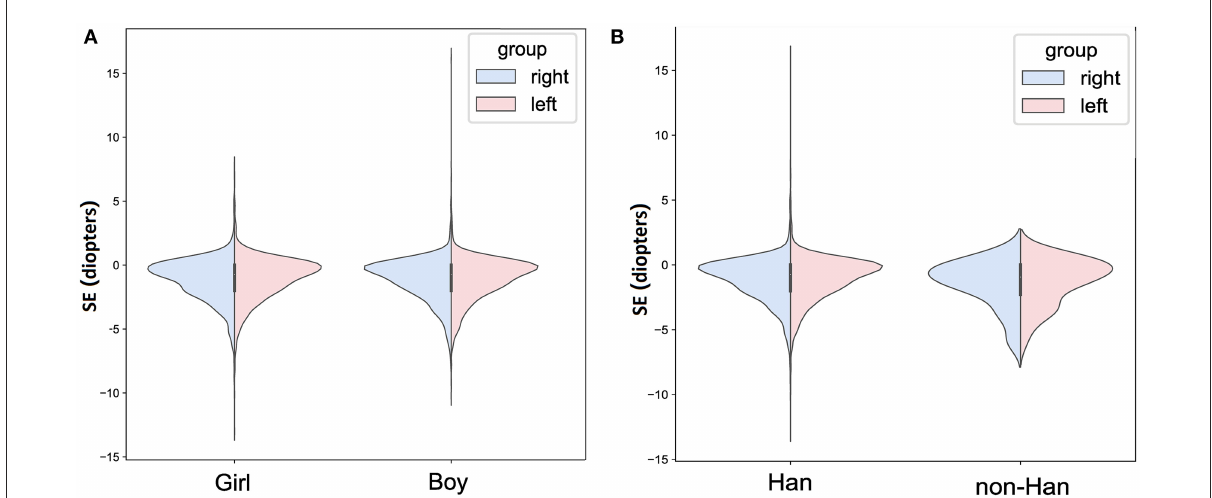
FIGURE1 The bilateral spherical equivalent in different age or grade in primary-school students in Xi’an. (A) The bilateral spherical equivalent in different age; (B) the bilateral spherical equivalent in different grade. SE, spherical equivalent.